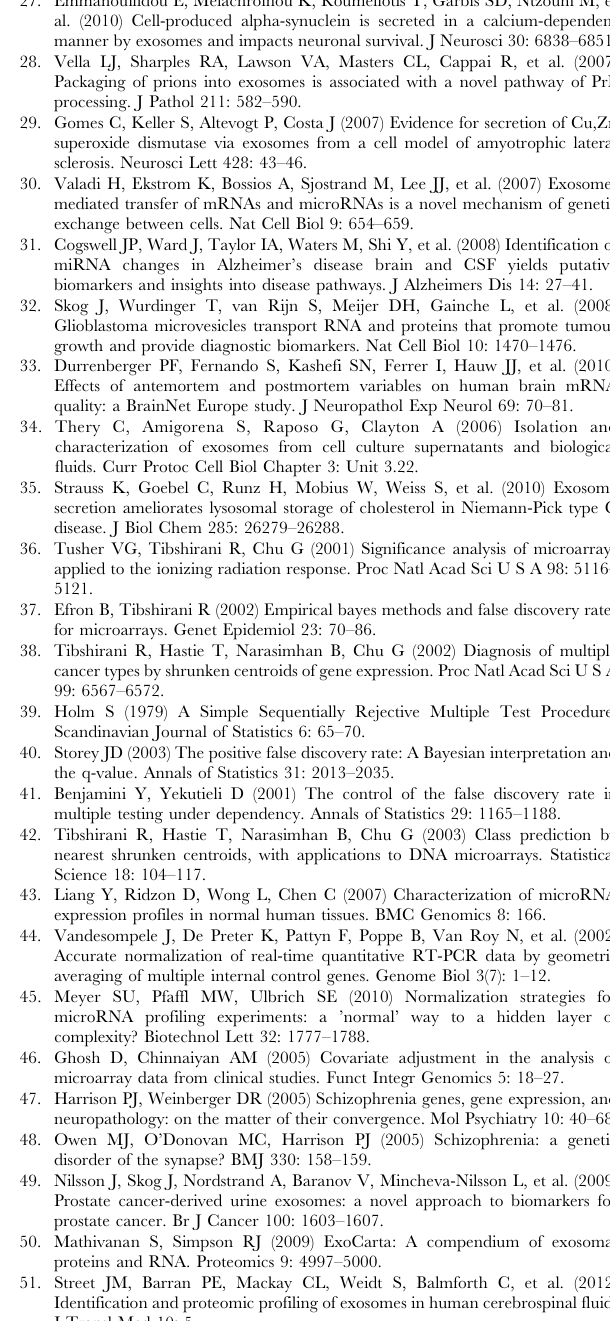
Table S4 Phenotype traits (tobacco, alcohol, and recre- ational drug use) of analyzed cases.